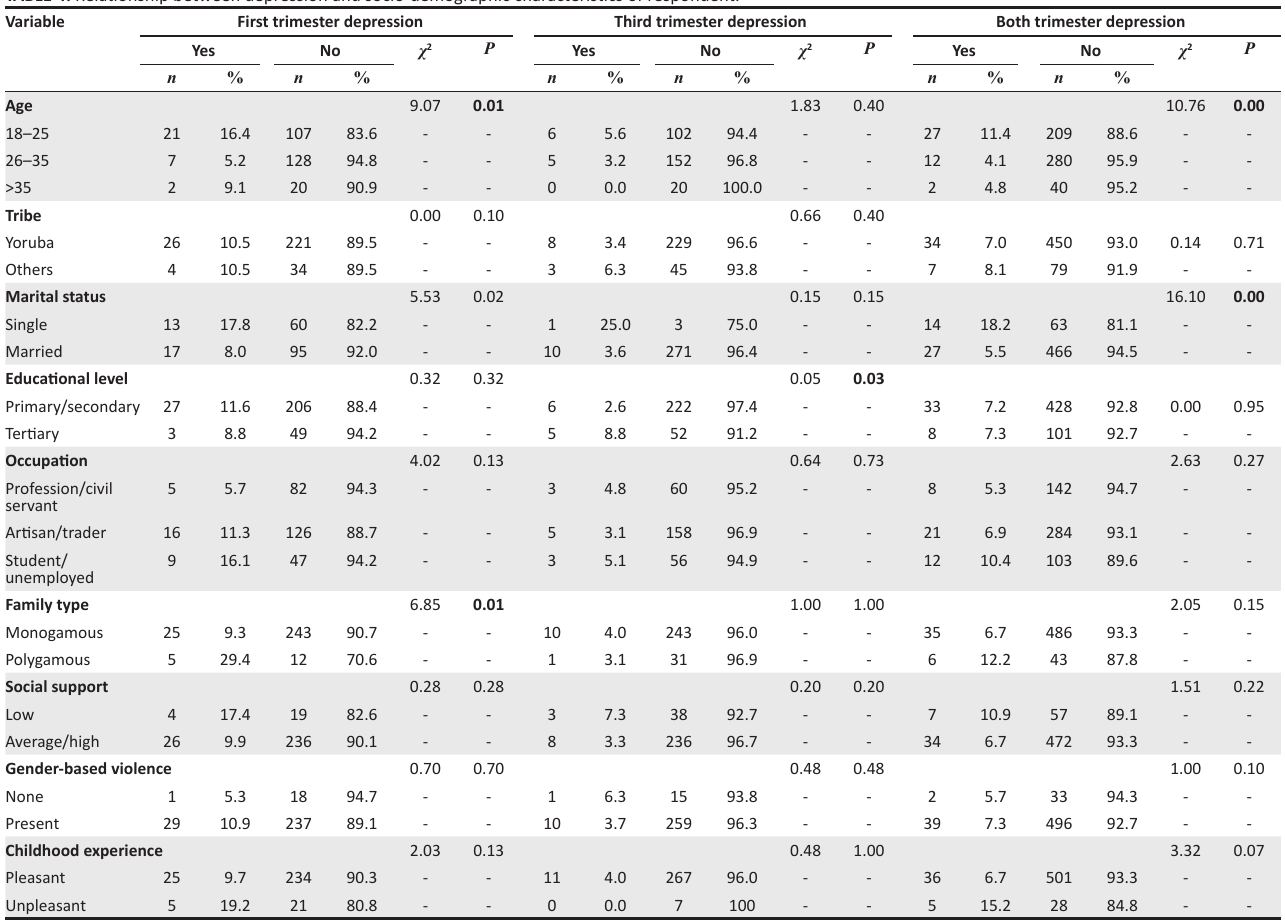
TABLE 4: Relationship between depression and socio-demographic characteristics of respondent. Variable First trimester